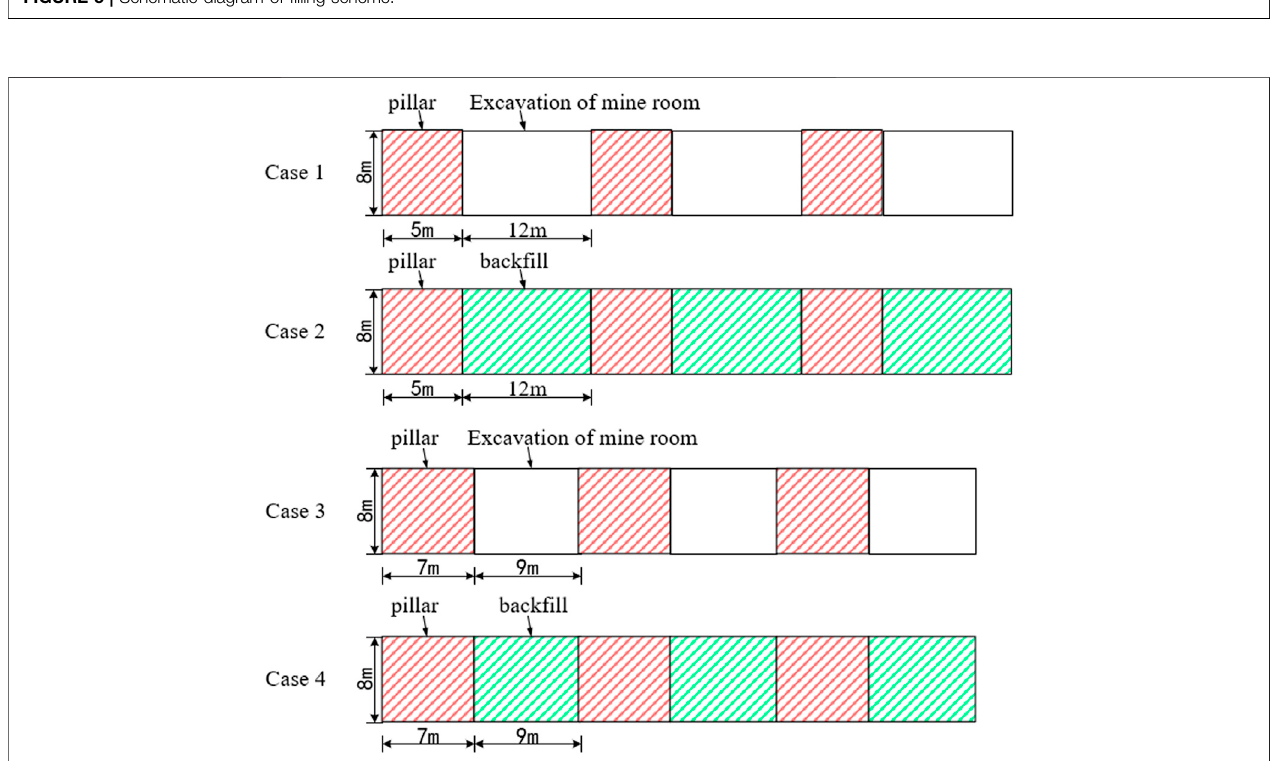
FIGURE 6 | Schematic diagram of mining